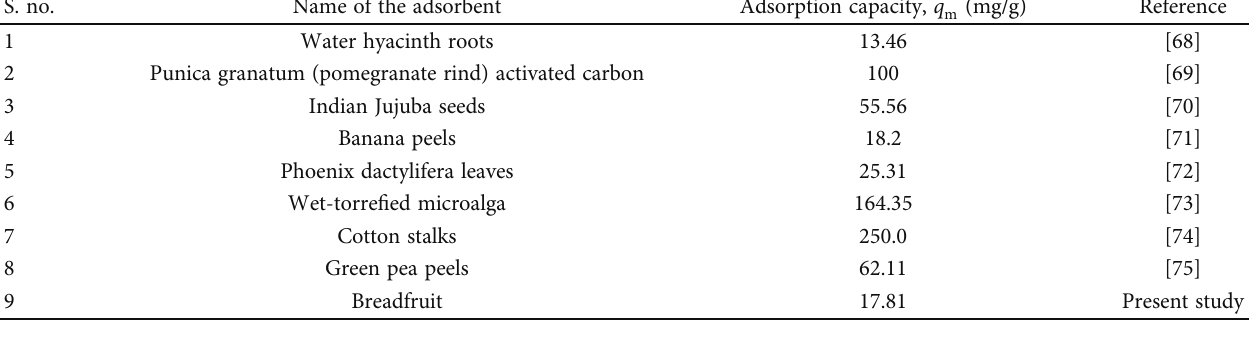
Table 8: Comparison of adsorption capacity of breadfruit leaf biochar with other biochar adsorbents for Congo red dye adsorption. S. no.